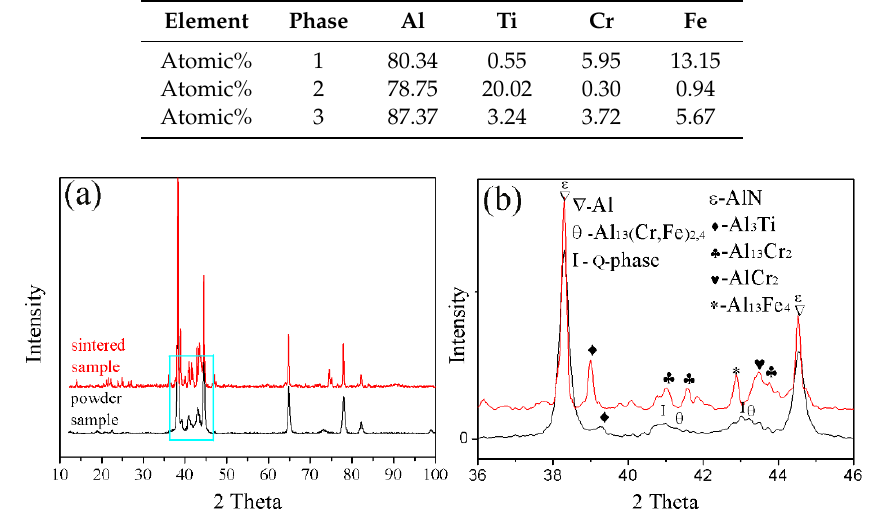
Figure 5. XRD pattern of the powder and sintered samples: ( a ) full scan from 10 to 90 °. ( b ) enlargement of the 36 to 46° section.